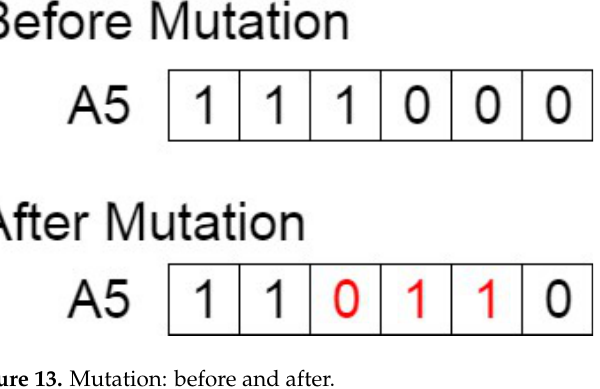
Figure 13. Mutation: before and after.